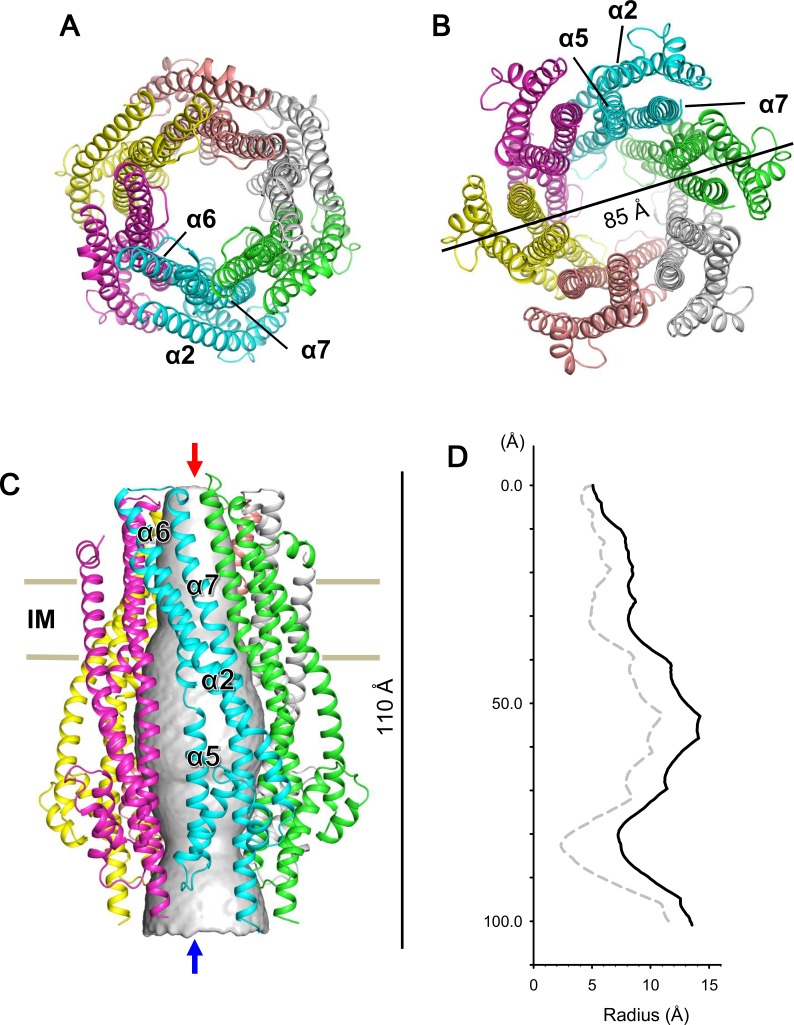
Crystal structure of the ExbB hexamer.(A) Viewed from the periplasmic side indicated by a red arrow in (C). (B) From the cytoplasmic side indicated by a blue arrow in (C). (C) Viewed parallel to the membrane. Overlaid with volume rendering (Smart et al., 1996) inside the central channel. Long α-helices are labelled α2, α5, α6 and α7 for one subunit in cyan. See also Figure 2A. (D) Plots of the channel radii (Smart et al., 1996) of the hexamer (solid line) and pentamer (dashed line; Celia et al., 2016).